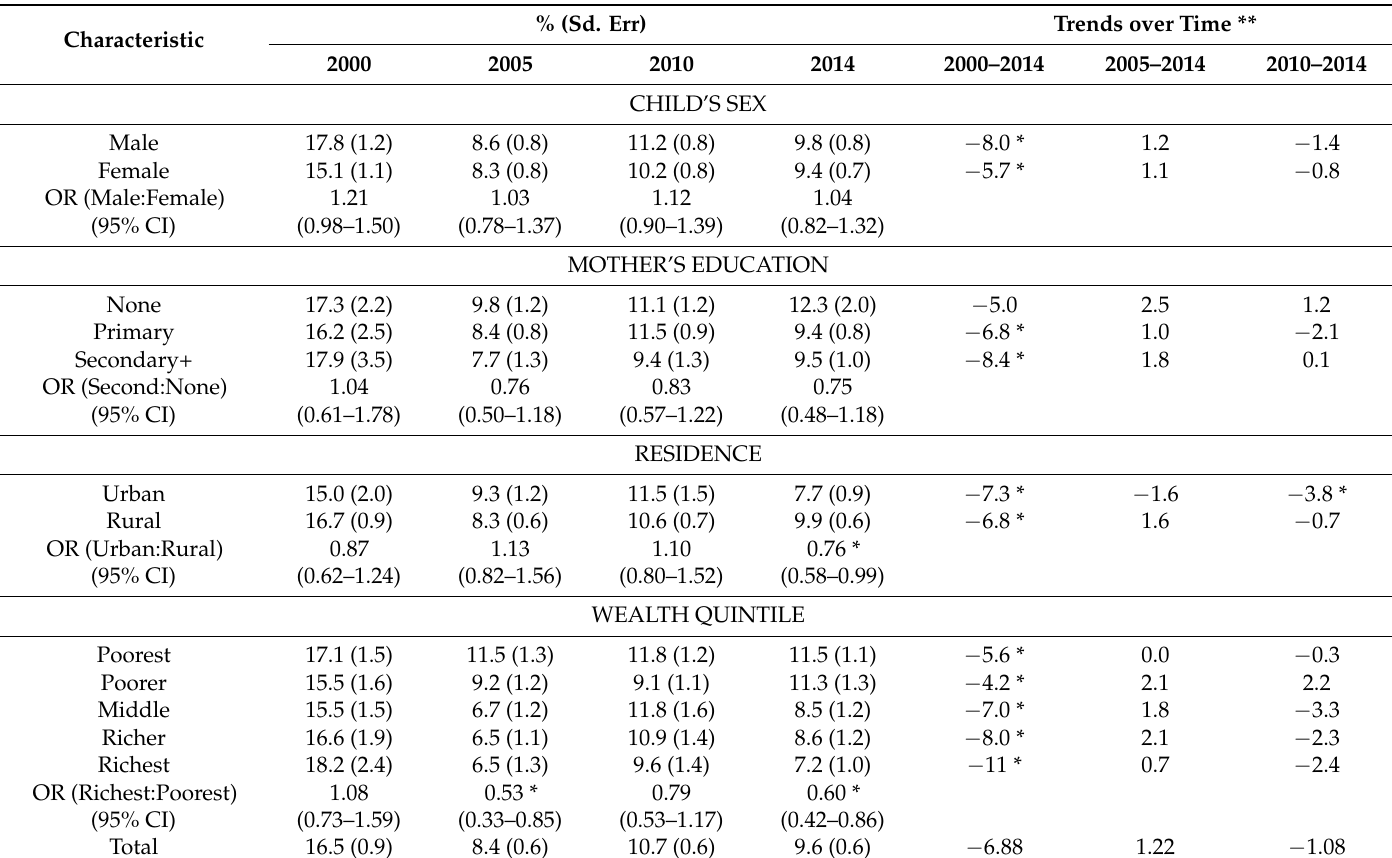
Table 3. Prevalence of wasting in children in the four surveys according to their social characteristics. % (Sd. Characteristic